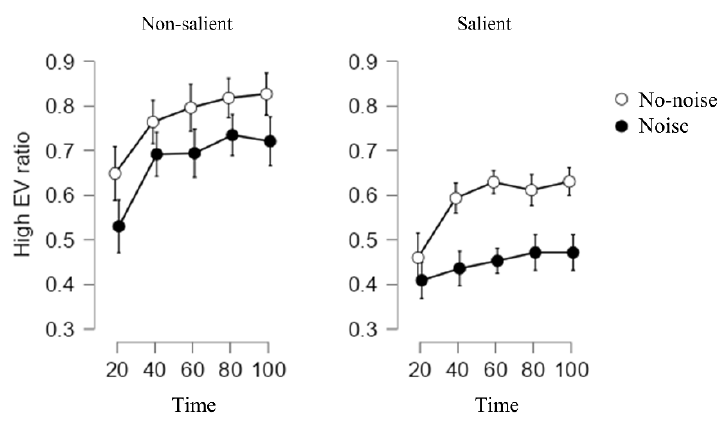
Figure 4. High-EV ratio in each condition of Study 2.